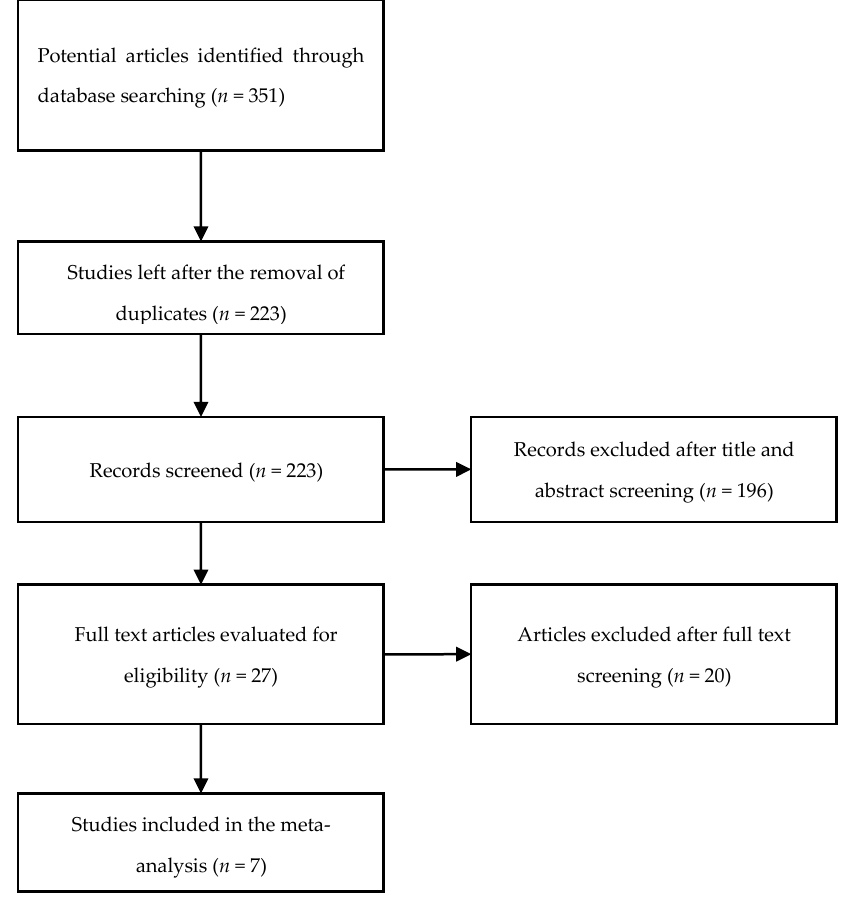
Figure 1. Study selection flowchart.